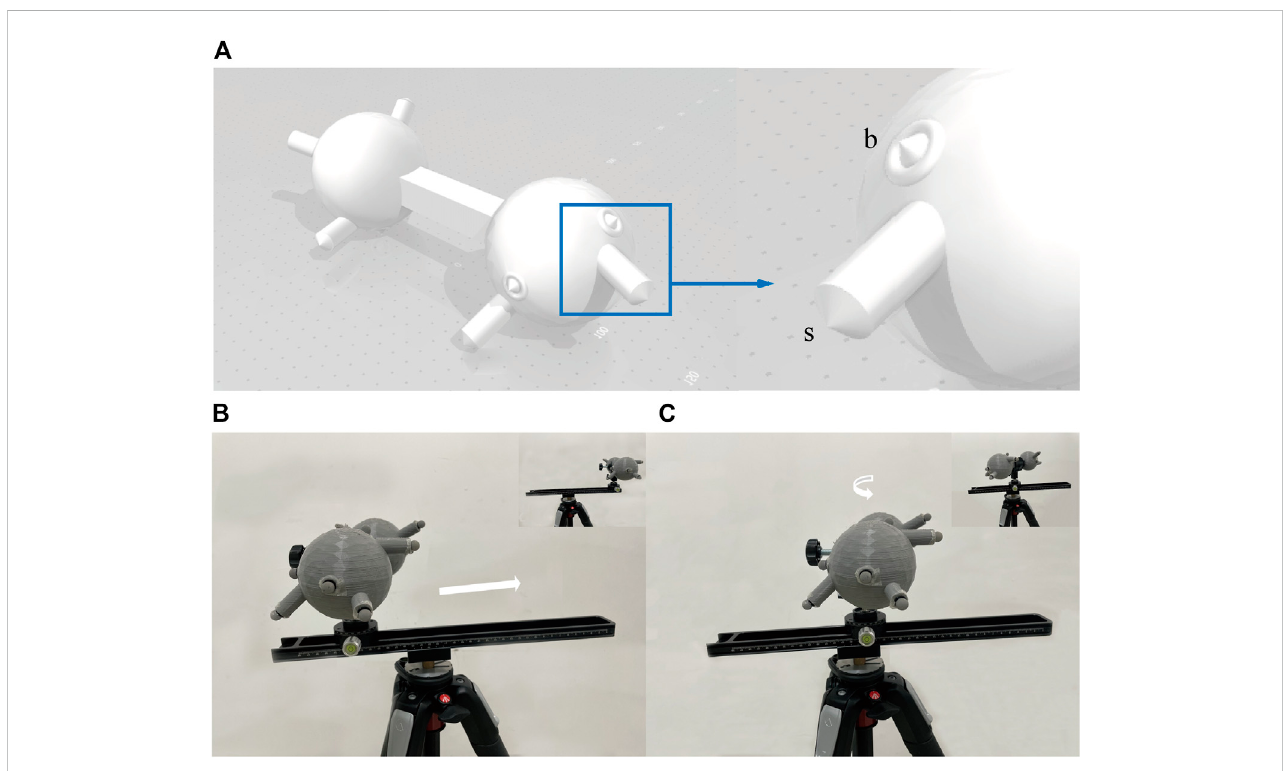
FIGURE 2 The3-Dmodelusedforvalidationanditsmotion. (A) Showsthe3Dsphereusedforveri fi cation.Thespheresimulatesthehumanbone.Thesectionatthe blue wire box magni fi es a set of landmarks, including the simulated body surface landmark ( s ) and the simulated bone landmark (B) . The sphere was printed withouttheconesbecausethere fl ectivemarkerswouldbeattached.Fivegroupswererandomlydistributedonbothsidesofthesphere.Thedistancesfrom s to b were not consistent amongst the 5 groups to simulate the different thicknesses between the body surface and the bone. (B) and (C) show the process of the model sliding 30 cm on the track and rotating 90 ° on the PTZ. Using a tripod as a support base, a macro track with a scale is tightened on the tripod, and a rotating PTZ with an angle value is attached to the slide. The track is not parallel to the ground, ensuring a 3-D transformation when moving on thetrack instead of a horizontal change.The attached markers are placed into thepre-set position inthe CAD of theprinted model,and themodel is secured to the PTZ with a U-shaped